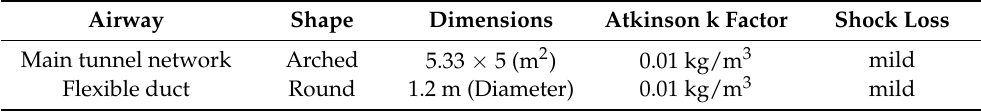
Table 1. Characteristics of the two types of airways.